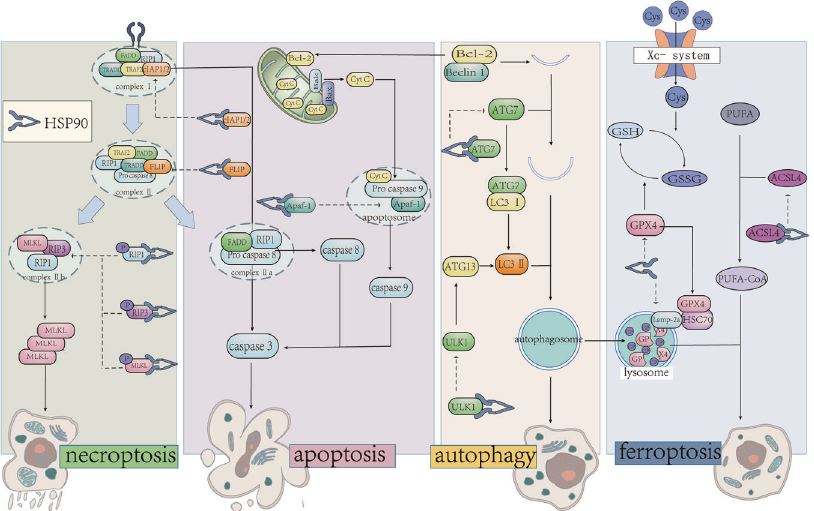
Fig. 3 HSP90 mediates multiple PCD. HSP90 plays an important role in the PCD regulation network. Forming complex with co-chaperone and clients to regulate their phosphorylation and stability is the main mechanism. And the clients of HSP90 are distributed in various processes, including the RIP1, RIP3 and MLKL in necroptosis, Bcl-2 and cellular-FLICE inhibitory protein (FLIP) in apoptosis, ULK1 and ATG7 in autophagy, GPX4 and ACLS4 in